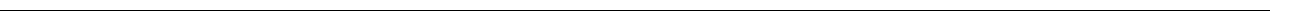
Figure 2 | Proteomic analysis reveals proteome diversity across frequently used OvCa cell lines. ( a ) Total number of quantified proteins in 26 OvCa cell lines, two immortalized ovarian surface epithelial cell lines (IOSE) and two cervical cancer cell lines ( n ¼ 3 measurements for each cell line). A median depth of 7,812 quantified proteins across all the samples was obtained. ( b ) Quantification of proteins with low and high standard deviation (s.d.) across all the 30 cell lines identified constantly or variably expressed proteins. Protein level variability (s.d., log10) and protein intensity (sum of the intensity-based absolute quantification (iBAQ) values, log10, calculated by MaxQuant) were compared for each protein in all cell lines. An s.d. cut-off of 0.5 was used to identify proteins with the highest variability (13% of total proteins; s.d. 4 0.5; dashed line). Proteins frequently altered in OvCa are highlighted in blue. Proteins associated with ribosome biogenesis (Gene Ontology Biological Process), shown in green, display small differences in expression across cell lines. CDKN2A is depicted twice, representative of two different isoforms. ( c ) Known genomic alterations are captured at the protein level. The relative protein intensities (MaxLFQ) for proteins whose genes have known amplification events in OvCa cell lines are depicted in red. HNF1B, an ovarian CCC marker, is shown in orange. ( d ) Coverage of cancer-related KEGG pathways. KEGG annotations, including cancer-related pathways, were applied to the data. Percentages of pathway coverage in the indicated cancer-related KEGG categories are shown. Pathways involved in DNA replication and DNA repair, as well as metabolic annotations such as the citric acid cycle or fatty acid metabolism were almost completely covered ( 4 80%). Signalling pathways such as mTOR, p53 or TGF- b signalling are largely covered by 4 60%. ( e ) Pathway enrichment analysis using Fisher’s exact test (Benjamini–Hochberg false discovery rate o 2%) was performed for the proteins with the highest expression variability (proteins above dashed line in b